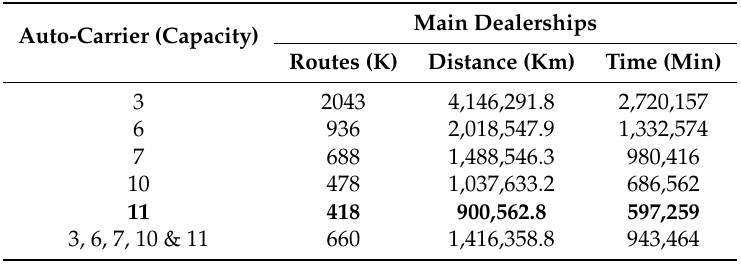
Table 9. Results of routing instance 11 with different